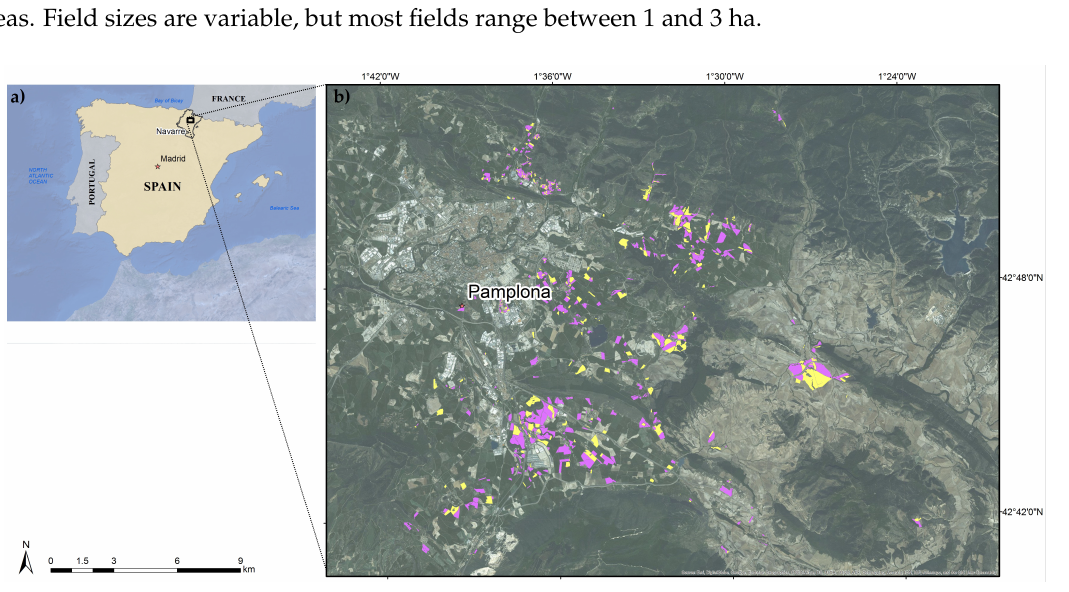
Figure 1. Location of the study area in Navarre, Spain ( a ) and ground truth data used over an optical image ( b ). Training and test set areas are presented in purple and yellow,